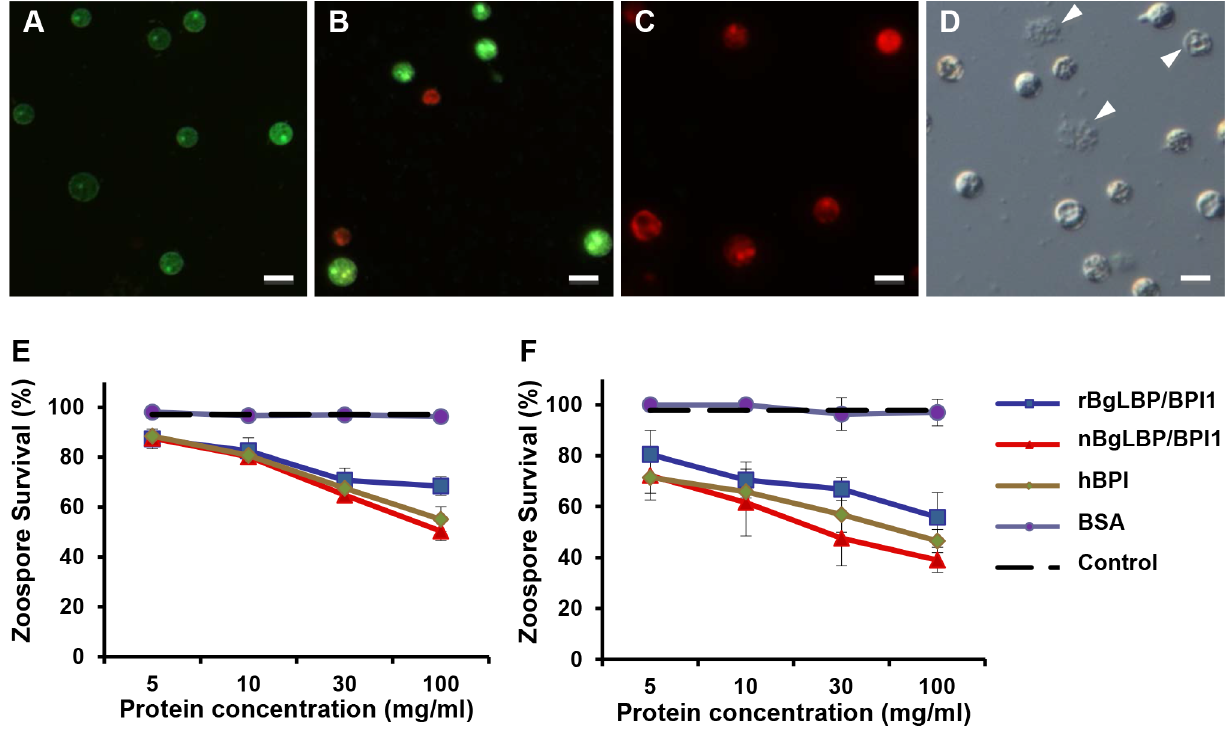
Figure 4. BgLBP/BPI1 and hBPI display anti-oomycete activity against Saprolegniaparasitica and S.diclina . (A–C) Pictures of live (green) or dead (red) Saprolegnia zoospores after exposure to BSA (A), or BgLBP/BPI proteins at 10 m g/ml (B) or 100 m g/ml (C). Zoospores have been stained by the live/dead cell assay (Abcam). Scale bar is 20 m m. (D) Phase contrast observation of zoospores exposed to 10 m g/ml BgLBP/BPI. Arrows show examples of dead cells or cell debris. (E, F) Survival rate of Saprolegnia parasitica (E) and S. diclina (F) after 30 min exposure to buffer alone (Control) or increasing concentrations of rBgLBP/BPI1, nBgLBP/BPI1, hBPI and BSA. Results are mean percentages ( 6 SE) of three independent experiments.